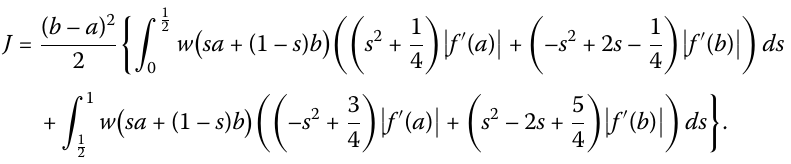
(cid:5)(cid:3) (cid:5)